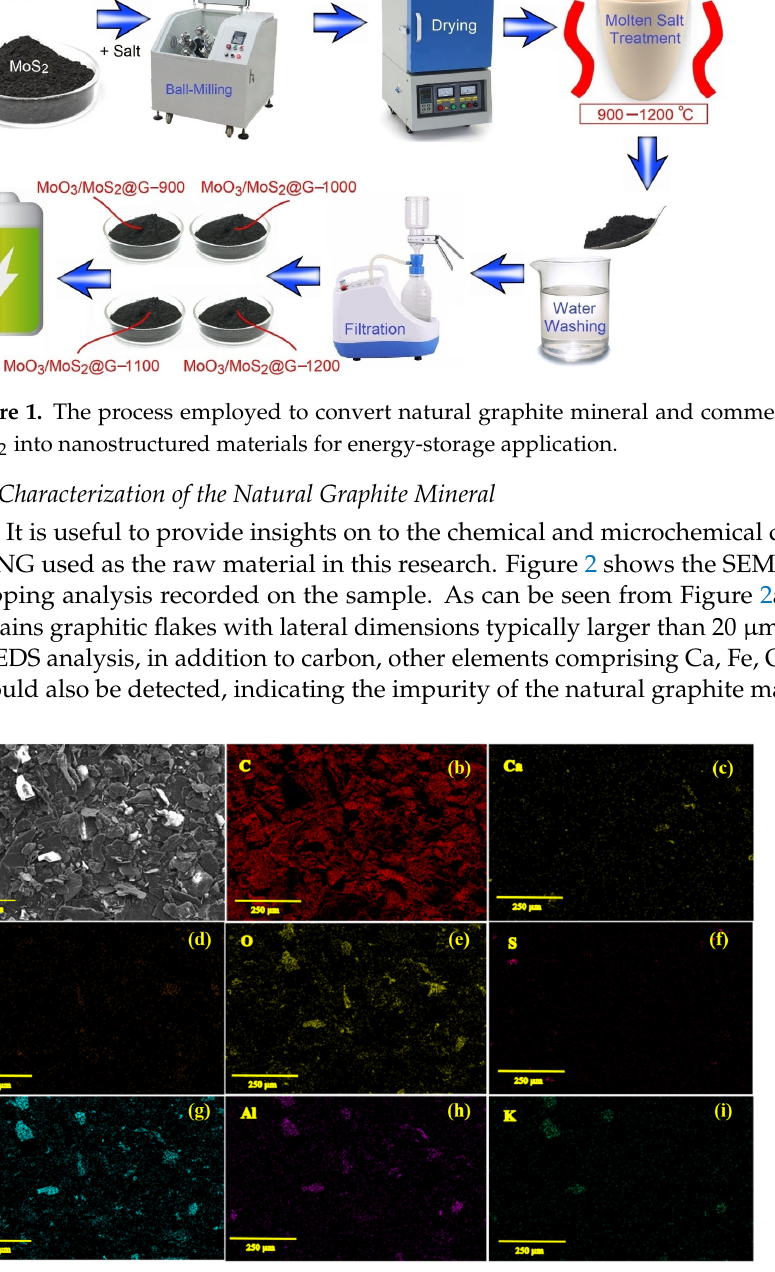
Figure 2. ( a ) SEM micrograph of the non ‐ purified natural graphite material, and ( b – i ) corresponding elemental EDS mapping analysis exhibiting the distribution of various elements. Table 1. Quantitative XRF analysis of the natural graphite material (wt%).